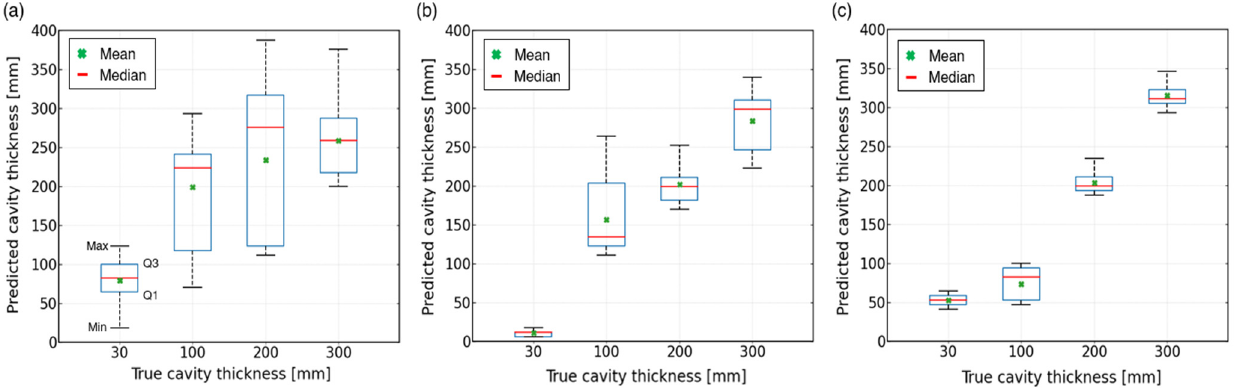
Figure 13. Variation of the predicted thickness of air-cavities based on the improved two-way travel time method applied to A-scan data measured by three different GPR antennas: ( a ) 400 MHz, ( b ) 900 MHz, and ( c ) 1600 MHz. Table 5. Summary of statistical parameters for distribution of predicted thicknesses of air-cavities shown in Figure 13.